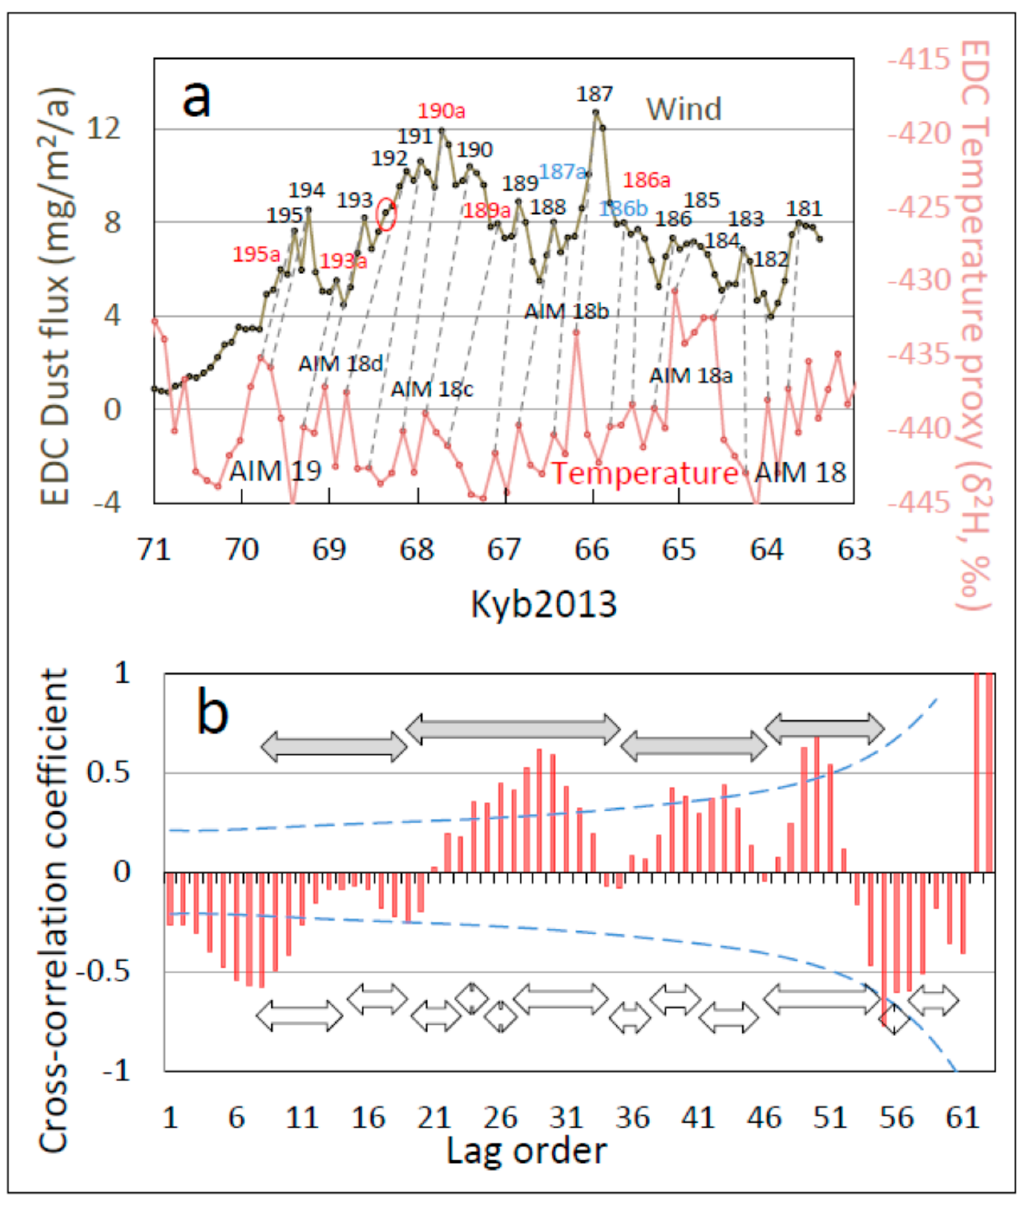
Figure 2. One-to-one coupling between temperature-proxy oscillations at EPICA Dome C (EDC) and dust flux (a wind proxy) at EDC for the time period from 71-63 thousand years before 2013 (Kyb2013). ( a ) 1:1 correspondence between wind-proxy cycles and identified temperature-proxy cycles. Corresponding peaks are connected by dashed lines to assist visualization of cross-record coherence. ( b ) Cross-correlation between temperature proxies and dust flux over the period 70-61 Kyb2013. The dashed blue lines in part b represent 95% confidence limits (positive and negative) for the value of the correlation coefficient associated with different lag orders (sample sizes). In this and subsequent figures, double-headed arrows demarcate the underlying periodicity visible in the cross-correlation record. Filled arrows show millennial-scale periodicity while open arrows designate cycles that recur with centennial-scale periodicity.